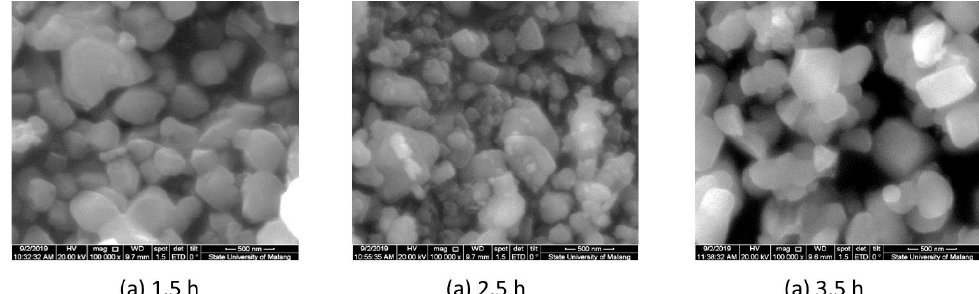
Figure 1. SEM morphology of ZnFe